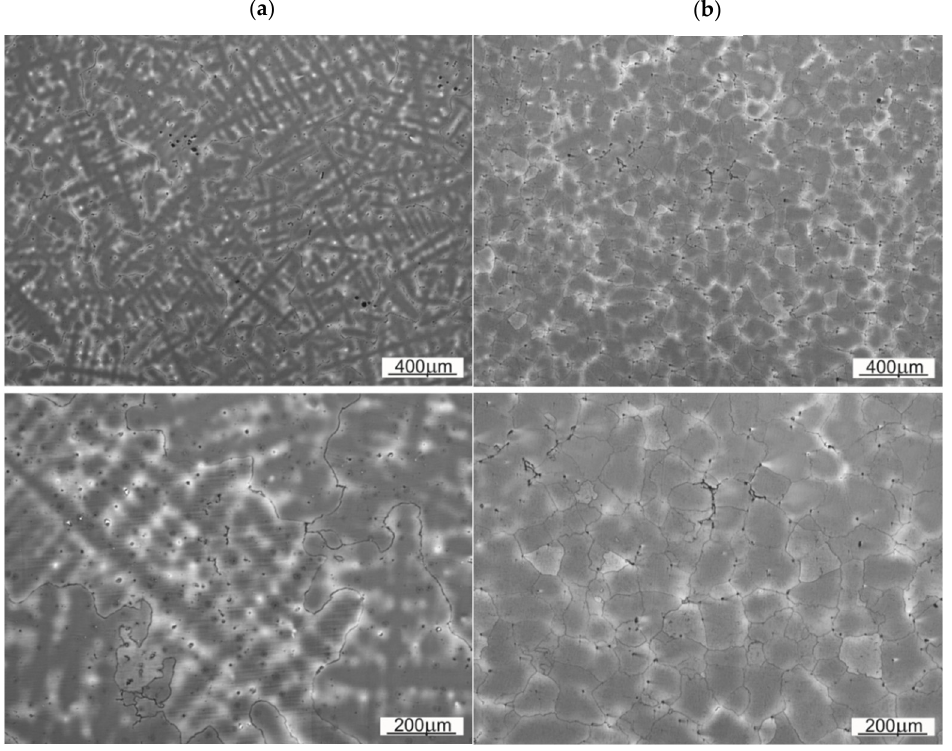
Figure 7. Base material microstructure: ( a ) sample SS1, ( b ) sample SS2.